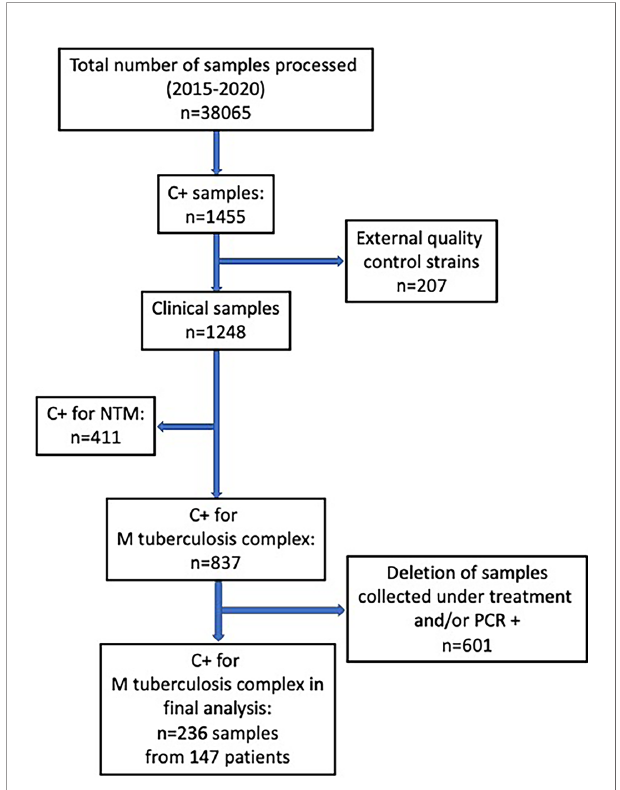
FIGURE 1 | Flow-chart of samples analyzed from the database of all positive culture results for mycobacteria at our institution over a 5-year